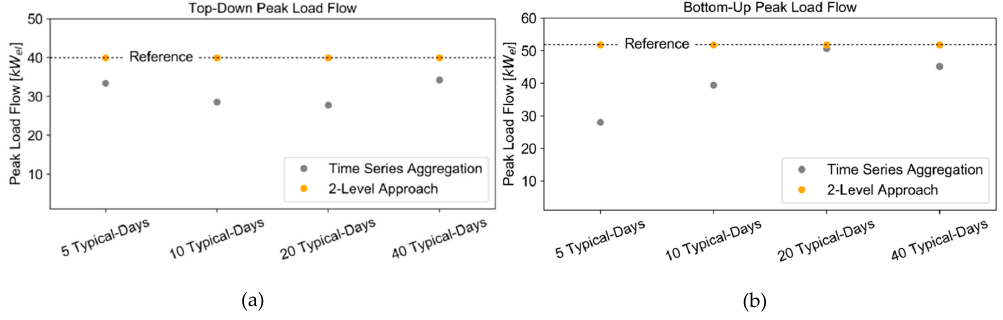
Figure 9. Top-down ( a ) and bottom-up ( b ) peak load flow of time series aggregation and 2-Level Approach compared to the reference case with full time series.